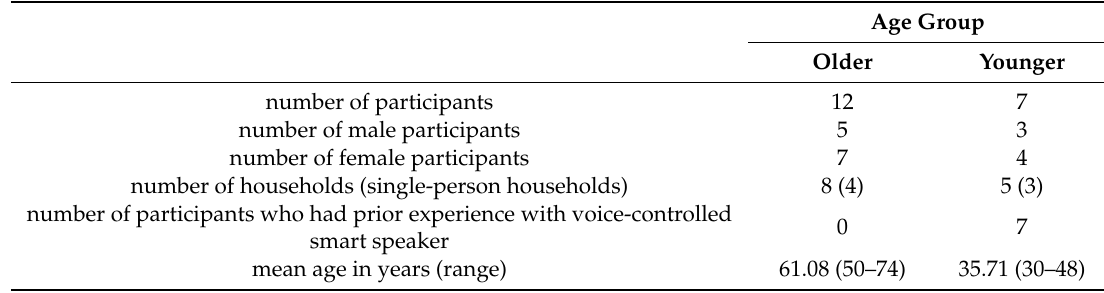
Table 1. Demographic information of age groups.